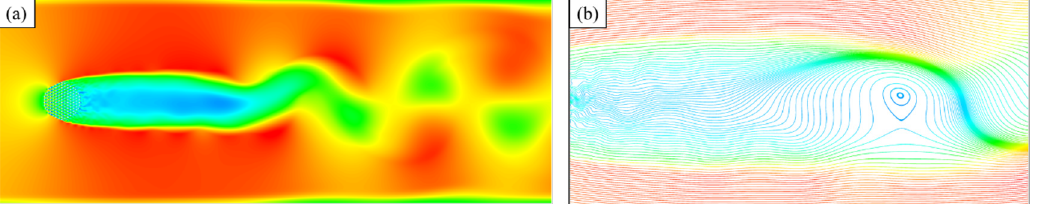
Figure 5. ( a ) Contour of longitudinal velocity u distribution of water flow obstructed by a vegetation patch, and ( b ) streamlines colored by velocity u near the stable wake segment; both are the numerical simulation results of SST k- 𝜔 turbulence model.